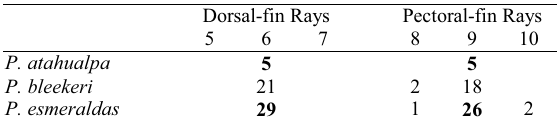
Table 23. Number of specimens of the species of Paracetopsis with cited number of dorsal and pectoral-fin rays. Bold indi- cates value for holotype when examined.